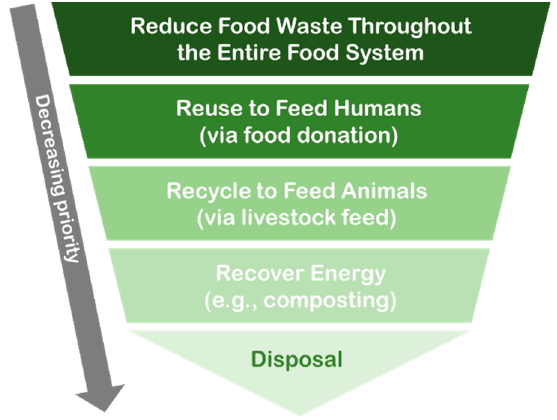
Figure 2. A simplified food waste hierarchy.